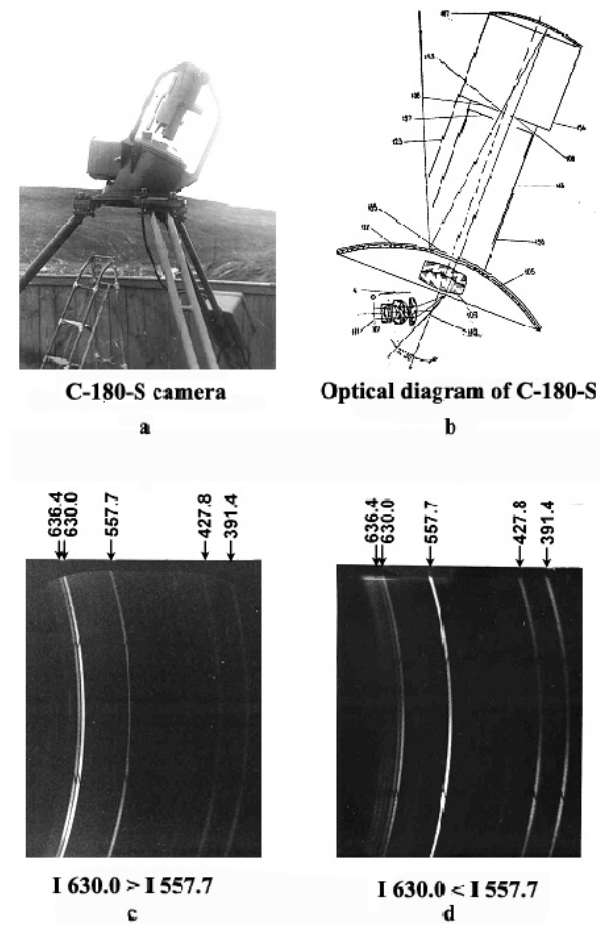
Fig. 5. Auroral spectral camera C-180-S (a, b) and typical auroral spectra obtained in Pyramida (c, d) .